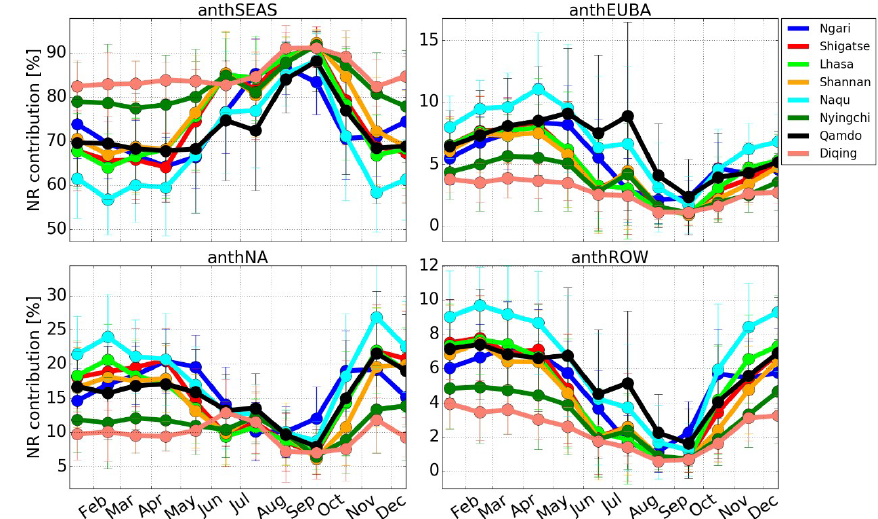
Figure 8. Monthly mean contributions of each geographical anthropogenic tracer to the total anthropogenic-associated CO transport to the HTP. The vertical error bar is the 1 σ standard variation within that month. See Table 2 for a description of each tracer.